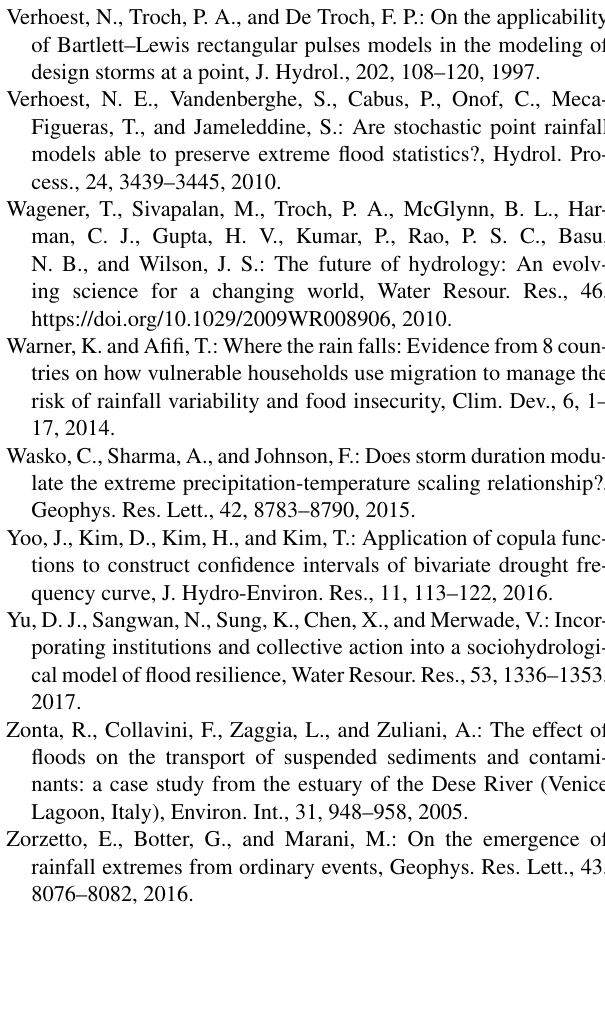
Figueras, T., and Jameleddine, S.: Are stochastic point rainfall models able to preserve extreme flood statistics?, Hydrol.